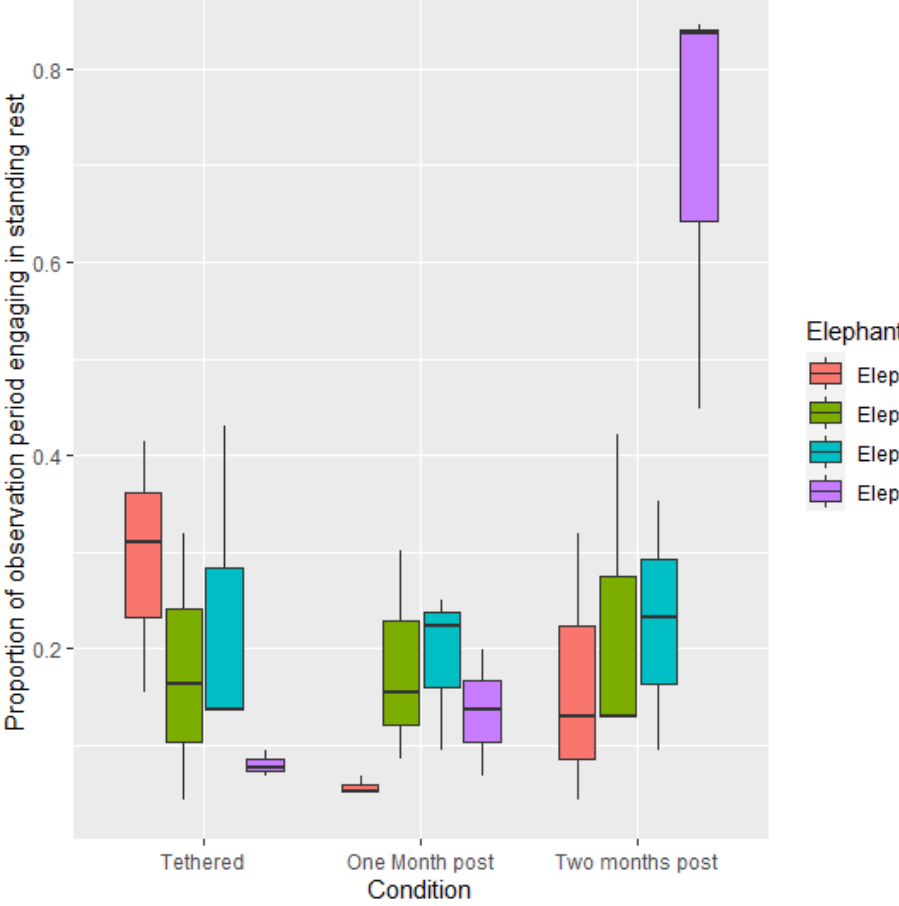
Figure 2. Mean proportion of time spent engaging in standing rest per observational period during the three conditions.